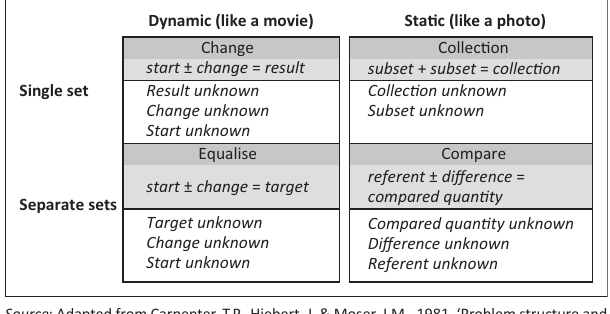
FIGURE 6: Names of subcategories created by changing the position of the unknown. FIGURE 7: Comparison of Riley’s and Van de Walle’s compare